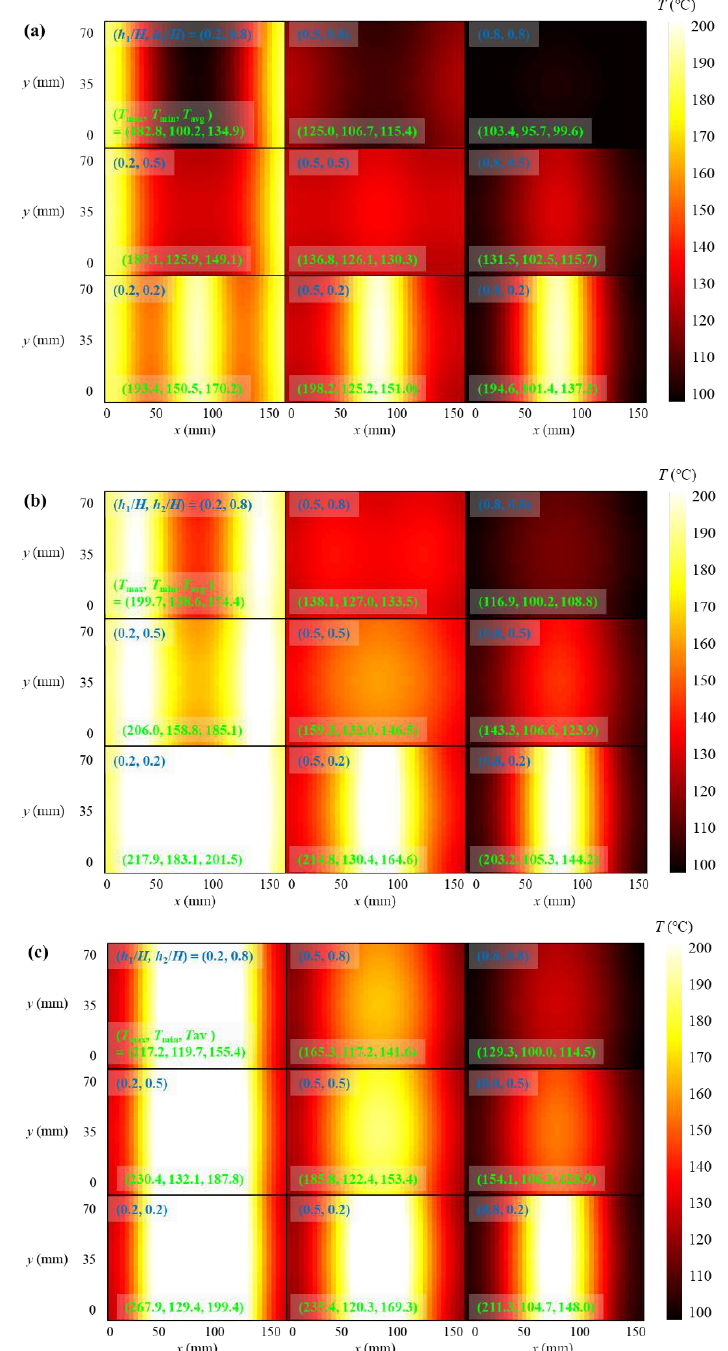
Figure 6. Temperature distribution of a glass panel within different ovens. Subgraphs ( a – c ) are associated with l / L = 0, 1/6, and 1/3, respectively. Each subgraph contains nine distributions. Three in the same row are results corresponding to h 1 / H = 0.2, 0.5, and 0.8 from left to right. Three in the same column are results corresponding to h 2 / H = 0.2, 0.5, and 0.8 from top to bottom.